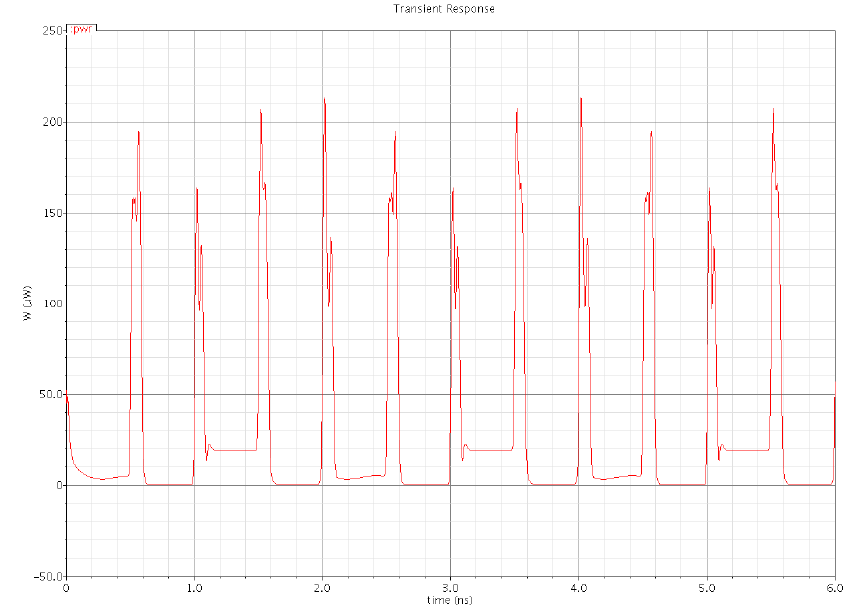
Figure 15. Total power dissipation in the PowerPC 603 master–slave latch. Figures 16 and 17 show the waveforms of power dissipations in the modified C 2 MOS latch and hybrid-latch flip-flop (HLFF). Figures 18 and 19 show the total power dissipation analysis using 65 and 130 nm process technologies and various types of input signals. Figure 20 shows the power analysis of various flip-flop and latch topologies using 65 and 130 nm process technologies and arctan(sin) as the input signal.